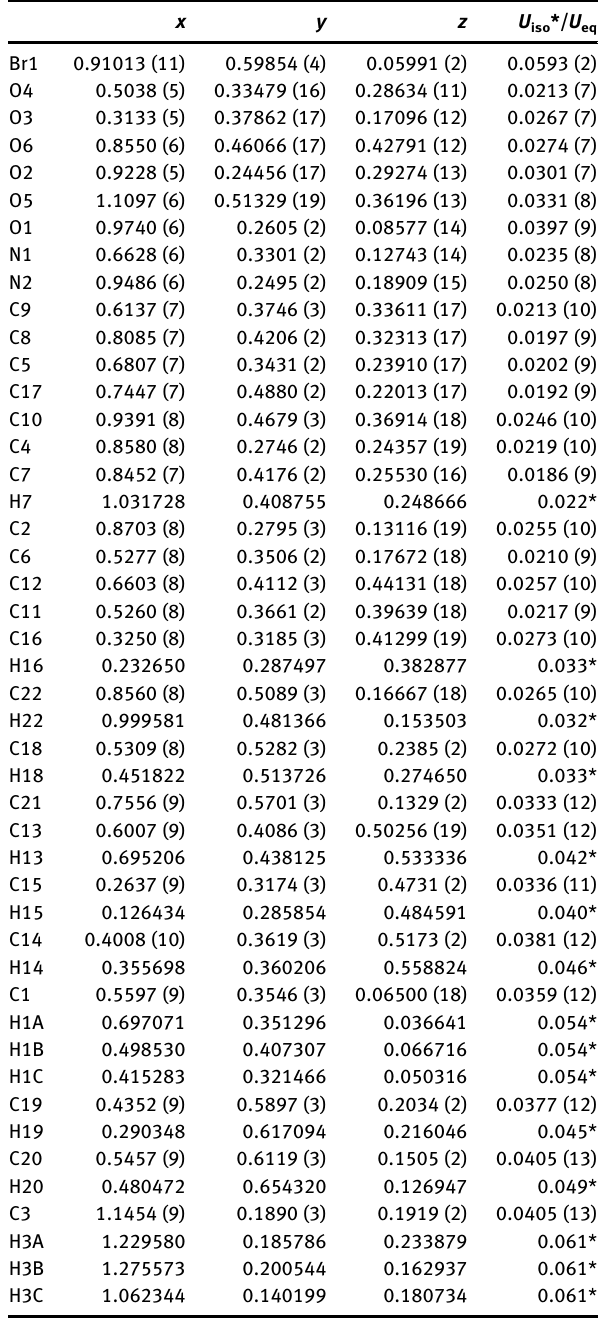
Table  : Fractional atomic coordinates and isotropic or equivalent isotropic displacement parameters (Å 